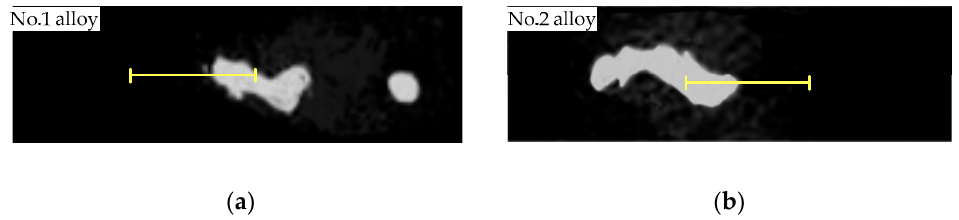
Figure 9. Liner EDS analysis of the Laves phase in ( a ) No.1 alloy and ( b ) No.2 alloy.